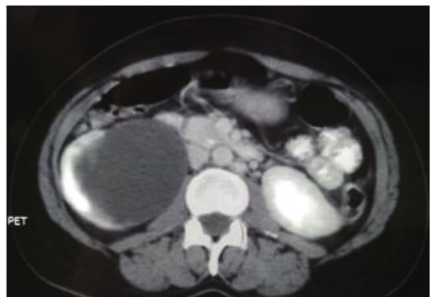
Figure 1: PET CT axial cut showing gross hydronephrosis of right kidney with thinned out parenchyma and left mild hydronephrosis.